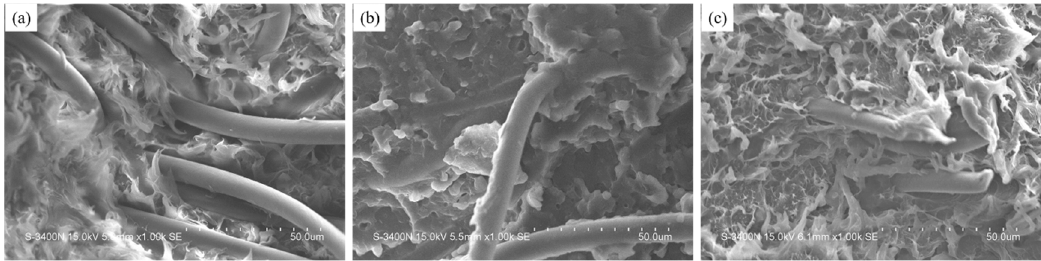
Figure 12. SEM images of PP composites filled with ( a ) untreated PET fiber, ( b ) MPP-modified PET fiber and ( c ) TMPP-modified PET